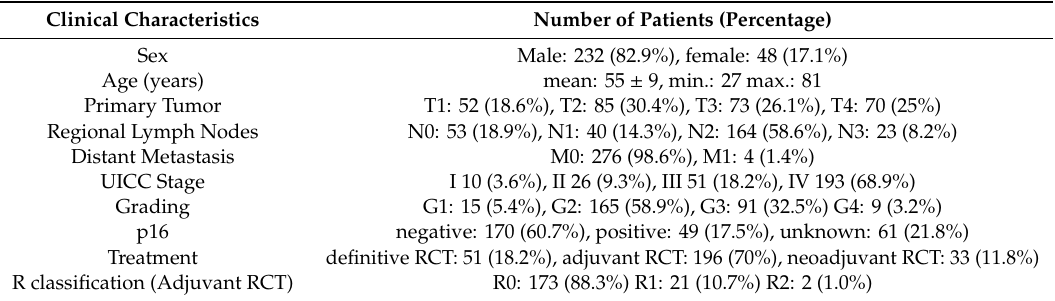
Table 1. Clinical characteristics of 280 head and neck cancer